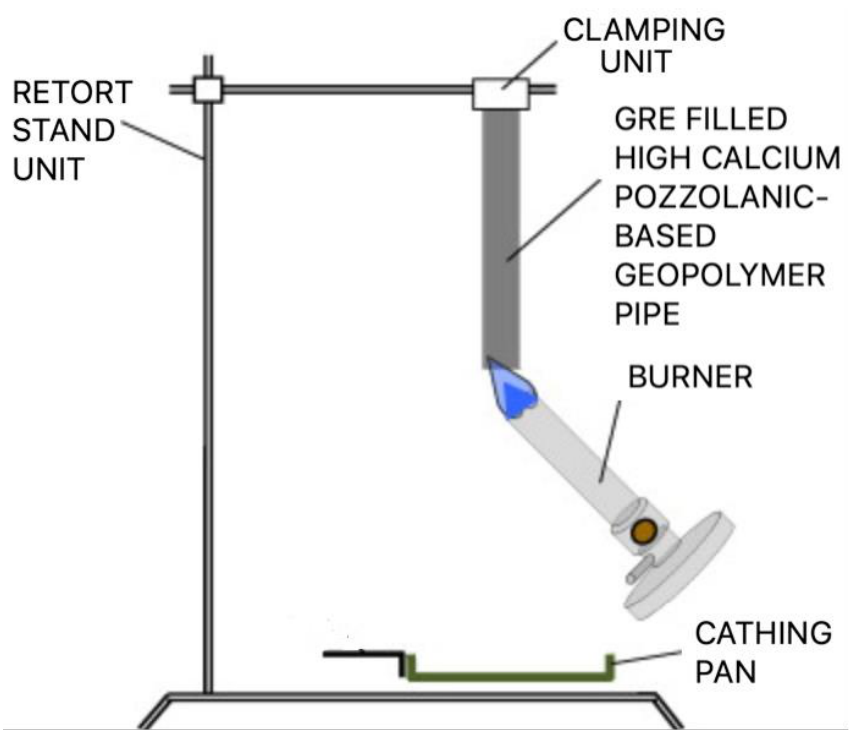
Materials 2022 , 15 , 6495